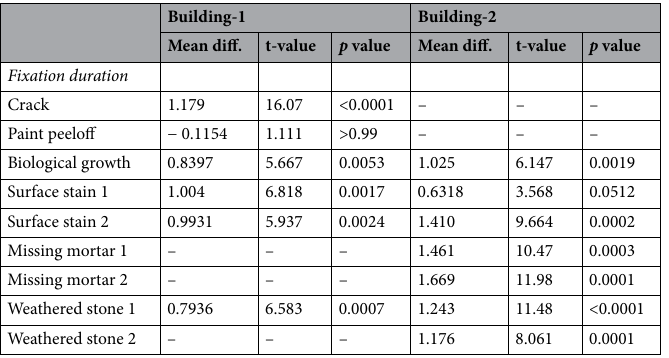
Table 2. Descriptive statistics of fixation duration for individual damage types showing their differences (see Supplementary Table 1, for detail on other metrics). For Building-1, there were no damage related to missing mortar and weathered stone 2 while crack and paint peeling off damage were not present for Building-2.